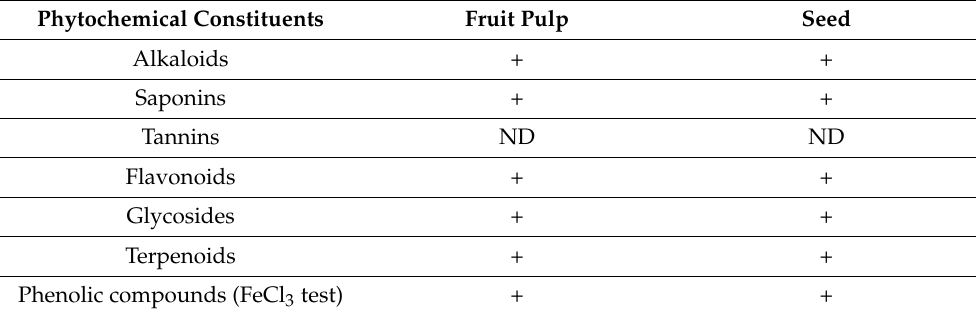
Table 2. Phytochemical screening of Ajwa fruit pulp and seed extract. Phytochemical